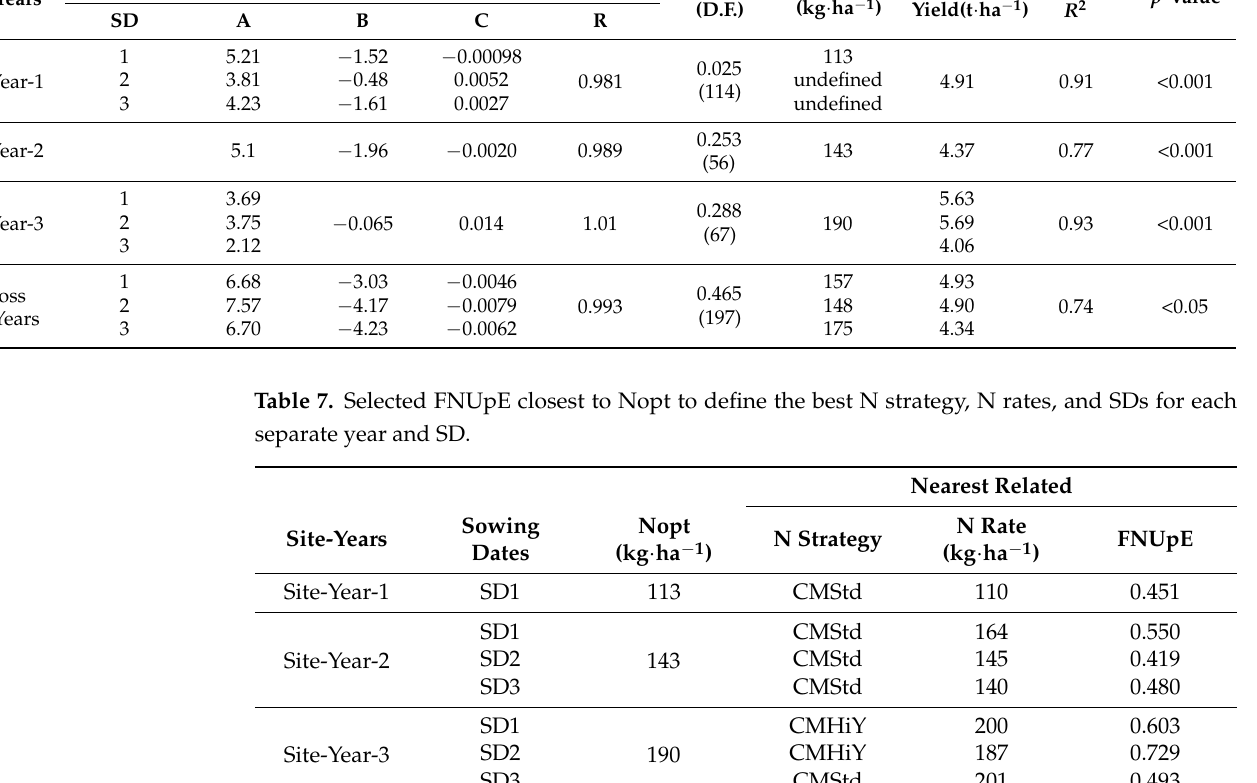
Table 6. Linear plus exponential fitted curve parameters between yield and N rates (Y = A + BR N + CN), S.E. is the standard error of the observation and D.F. is the degrees of freedom. Optimum N rate (Nopt), and yield at maximum economical point corresponded to Nopt; proportion accounted for variance as (adjusted R 2 ), and the p -values of the stepwise regressed function.